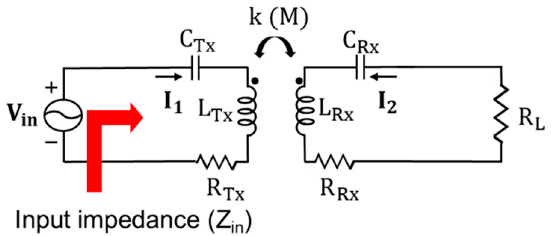
Figure 1. The equivalent circuit of a WPT system with an SS topology.